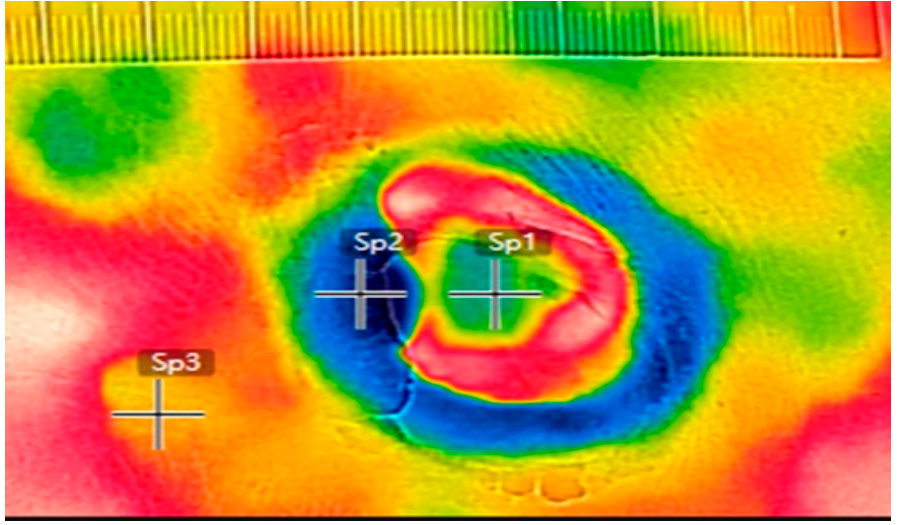
Figure 1. Infrared thermal imagery of a wound. Sp1: area of wound bed; Sp2: area of periwound skin; Sp3: area of normal skin.